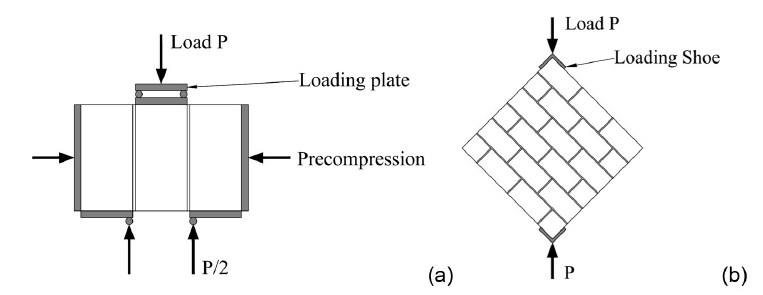
Figure 10. (a) Triplet test; (b) diagonal tension